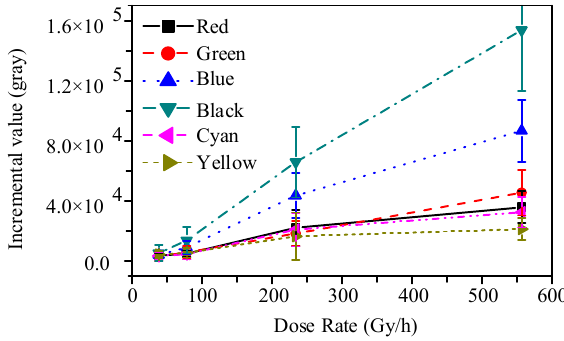
Figure 8. Mean grayscale incremental value of 4T-APS with different color backgrounds at the irradiation dose rates of 8, 78, and 557 Gy/h.